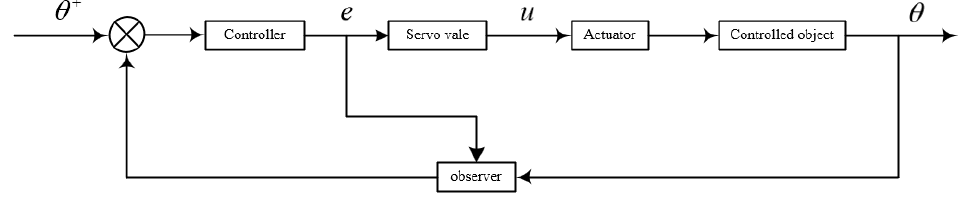
Figure 4. Finite-time compound control flow chart of the continuous rotary motor system.